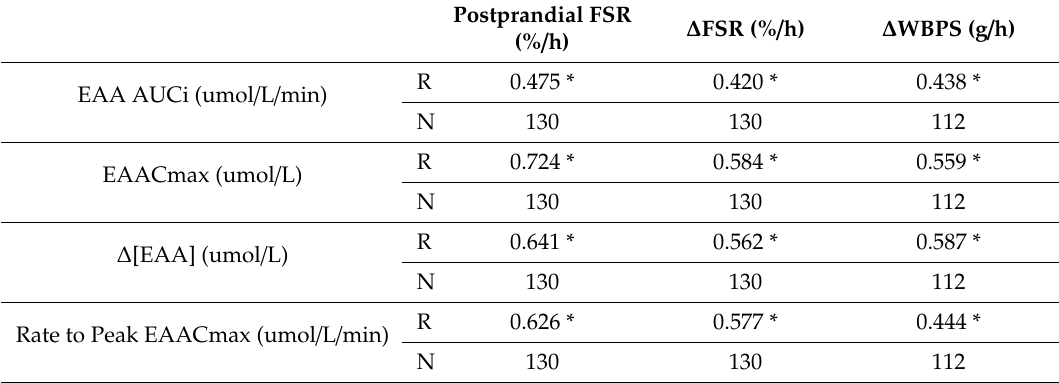
Table 4. Correlations between protein kinetics and essential amino acid (EAA) pharmacokinetics 1